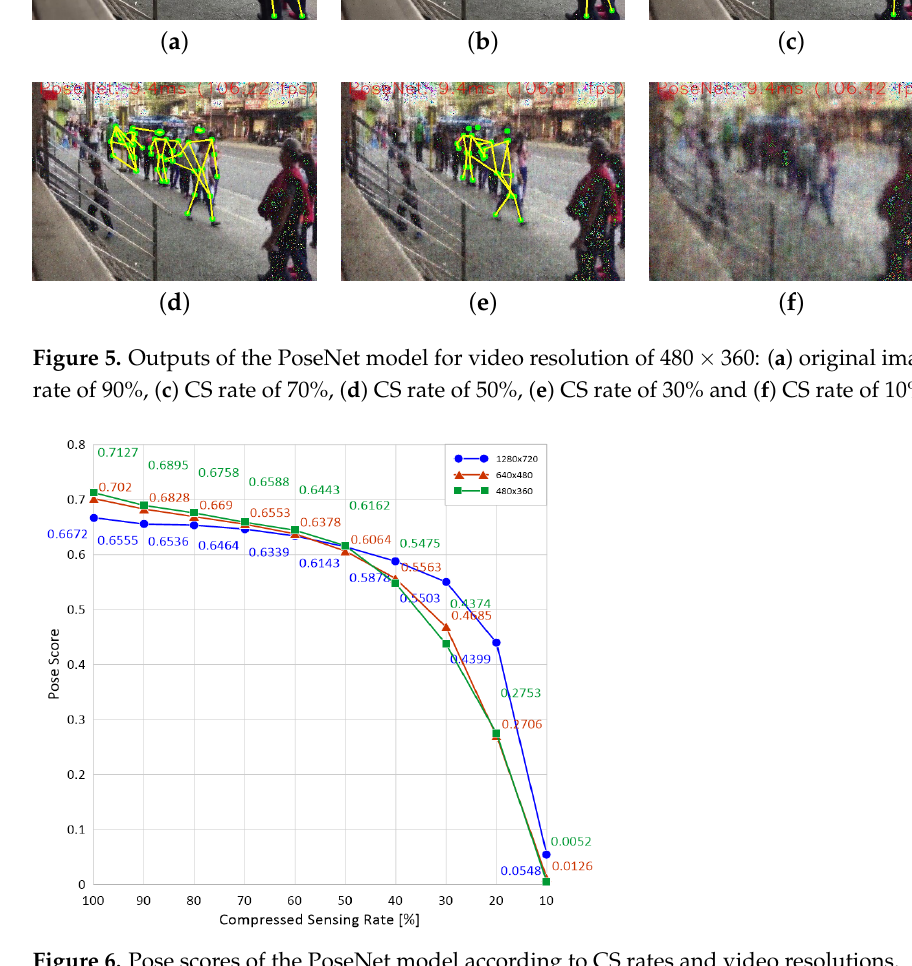
Figure 6. Pose scores of the PoseNet model according to CS rates and video